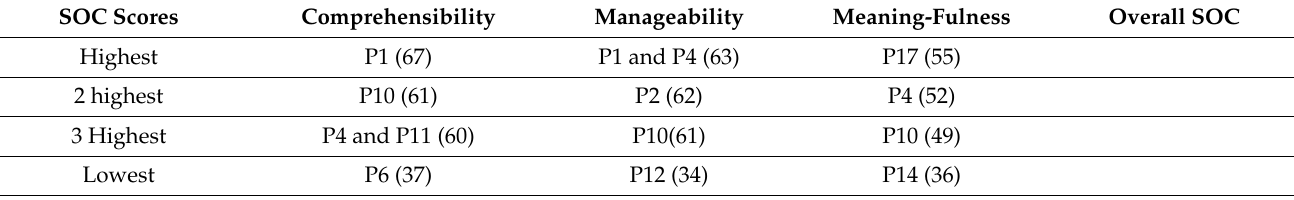
Table 3. Overview of SOC